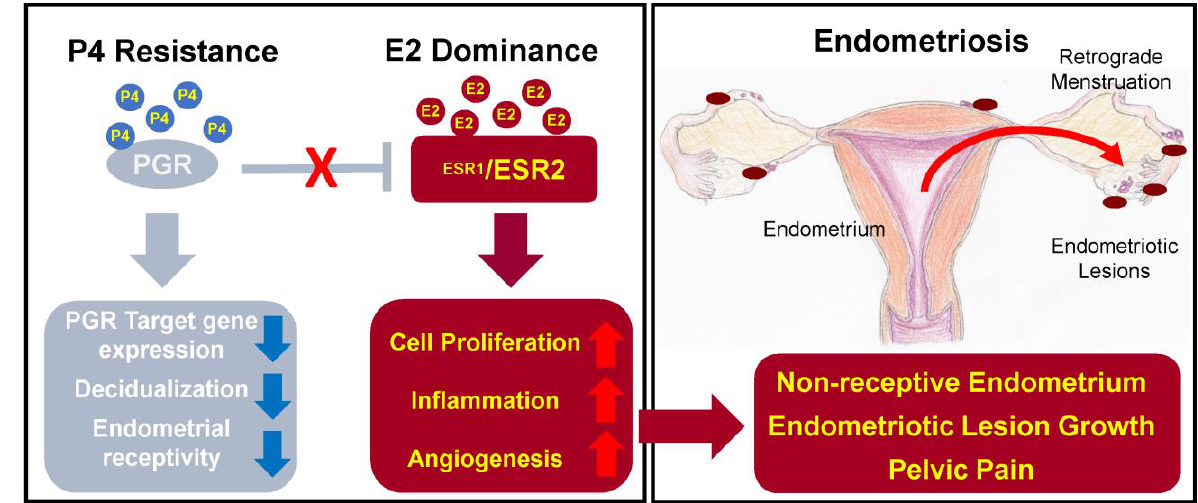
Figure 2. The effects of progesterone and oestrogen dysregulation on endometrium. Figure replicated from [38] under Creative Commons license, provided at https://creativecommons.org/licenses/by-nc/4.0/ (accessed on 17 January 2023). Changes made: Figure legend.